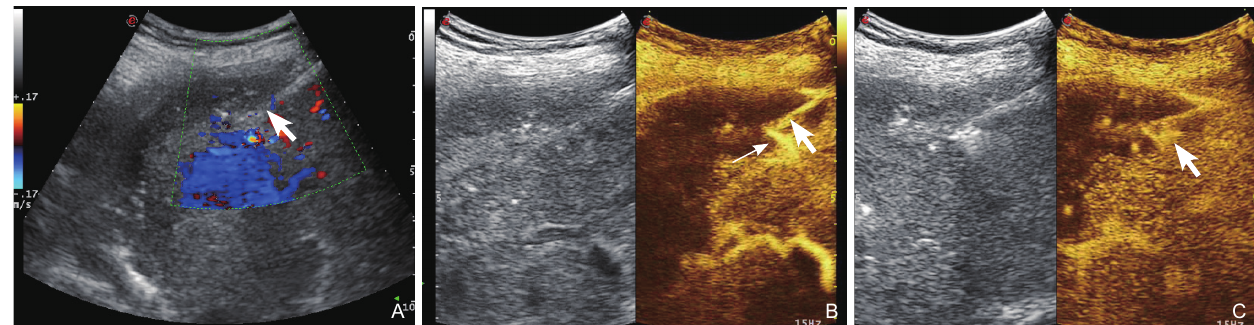
Figure 2 A 60-year-old male with abnormal coagulation function (platelet count was 44×10 9 /L). (A) The arrow showed that colour Doppler US did not detect the needle-tract bleeding; (B) CEUS showed the ultrasound microbubbles continuously overflowing from the ablation site to the liver surface along the needle tract. The short arrow showed the bleeding needle tract, and the long arrow showed the affected vessel; (C) The affected vessel and needle tract were ablated under the guidance of CEUS. The arrow showed the tip of the RFA